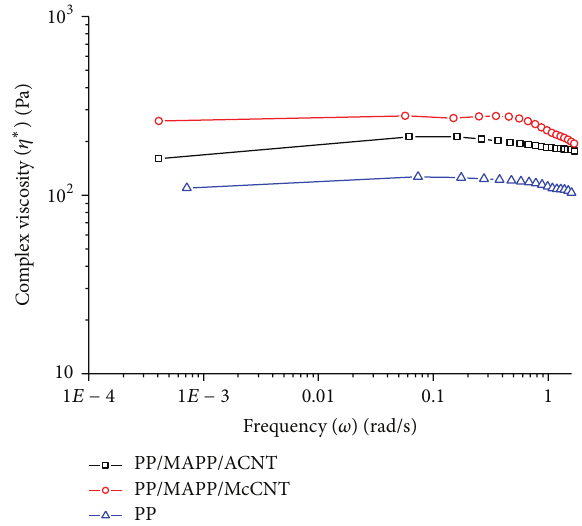
Figure 5: Tan 𝛿 versus temperature of PP and its nanocomposites. PP/MAPP/ACNT revealed the relatively strong interaction between McCNT and polymer matrix, causing the restricted polymer mobility.